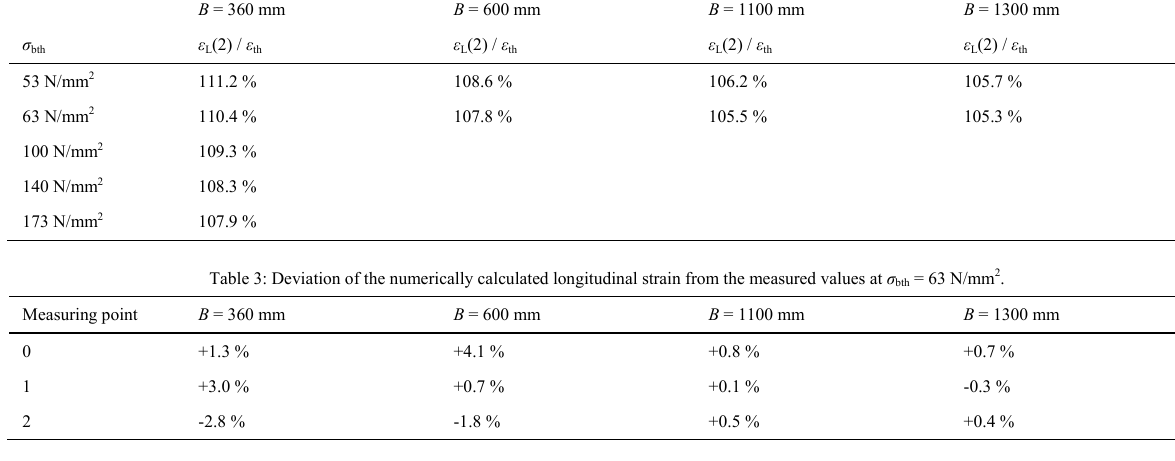
Table 2: Measured relative peak strains at the edges (2) with increasing specimen width B at different loads. B = 360 mm B = 600 mm B = 1100 mm σ bth